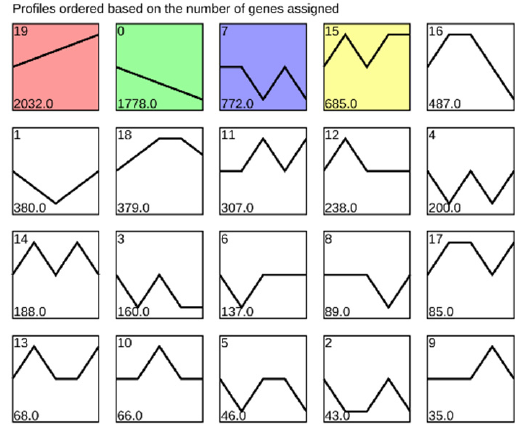
Figure 3. Expression profile clustering of all genes (FPKM ≥ 1) across the five developmental stages. Each box represents a model profile. The upper number in each box represents the serial number of each profile and the lower number is the number of genes in the model. The colored modules are statistically